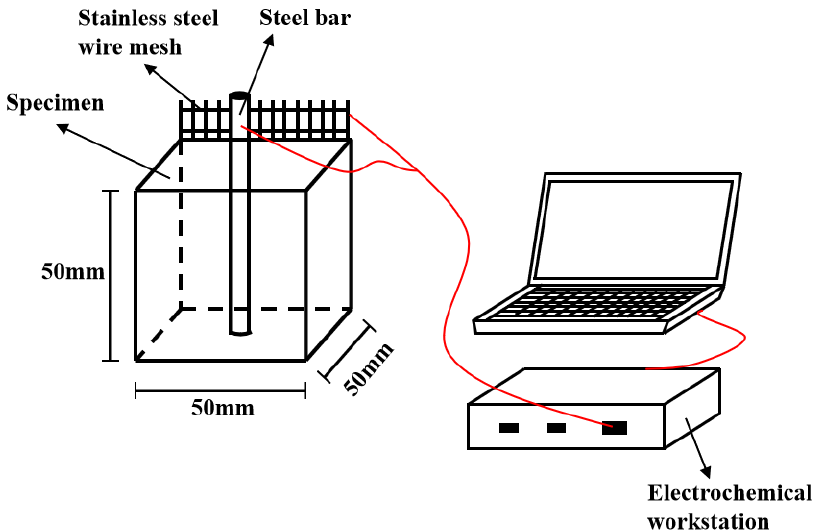
Figure 2. Measurement of AC electrical parameters.